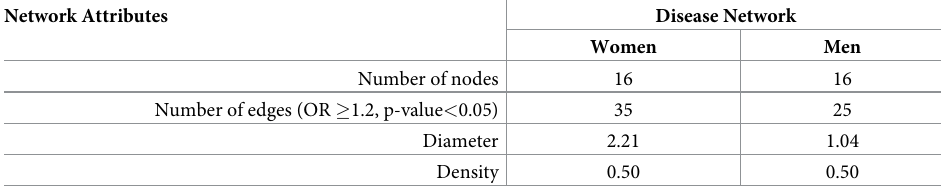
Table 2. Network specific attributes by gender in the older adult population with multimorbidity, Longitudinal Ageing Study in India, 2017–18. Network